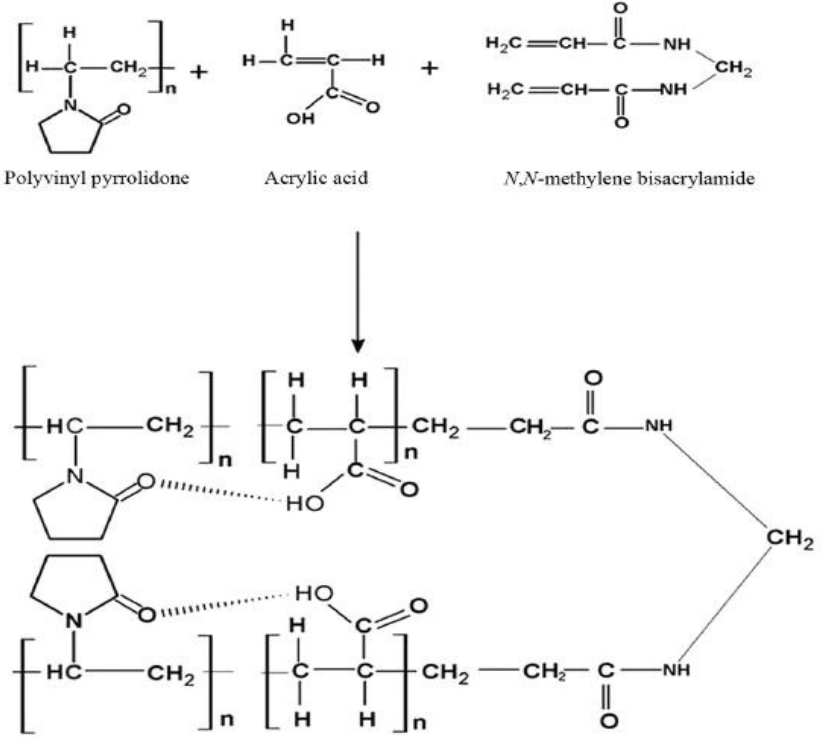
Fig. 3. Possible structure of polyvinylpyrrolidone/acrylic acid hydrogel.